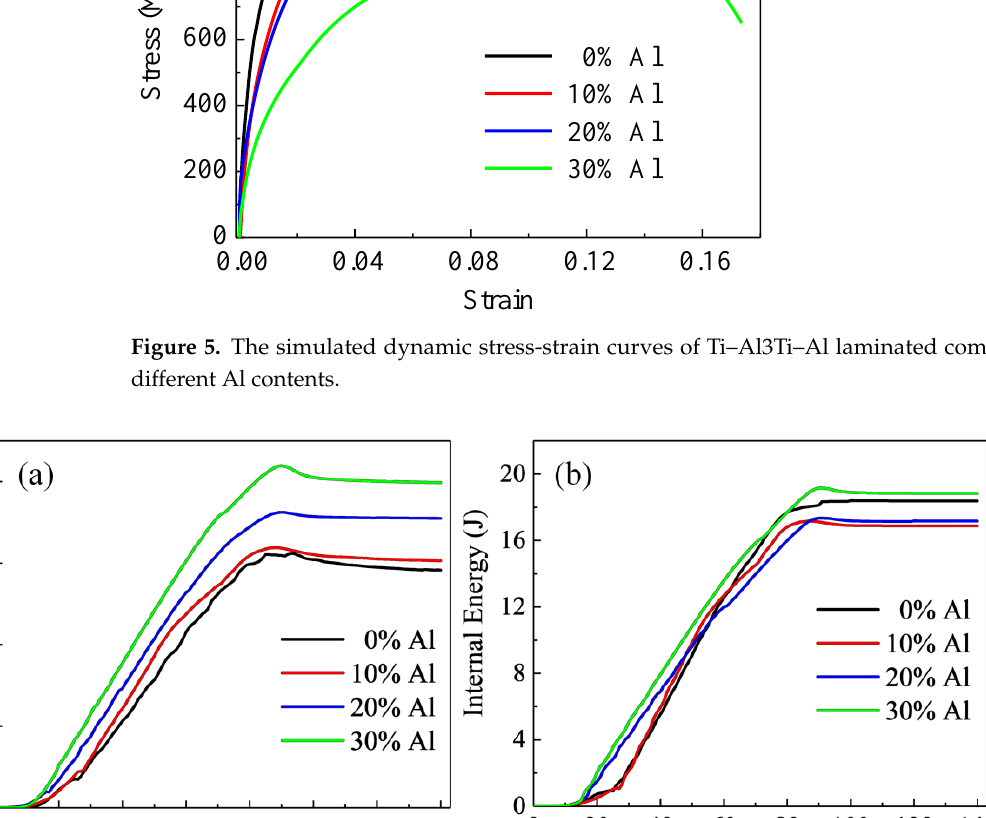
Figure 5. The simulated dynamic stress-strain curves of Ti–Al3Ti–Al laminated composites with different Al contents.